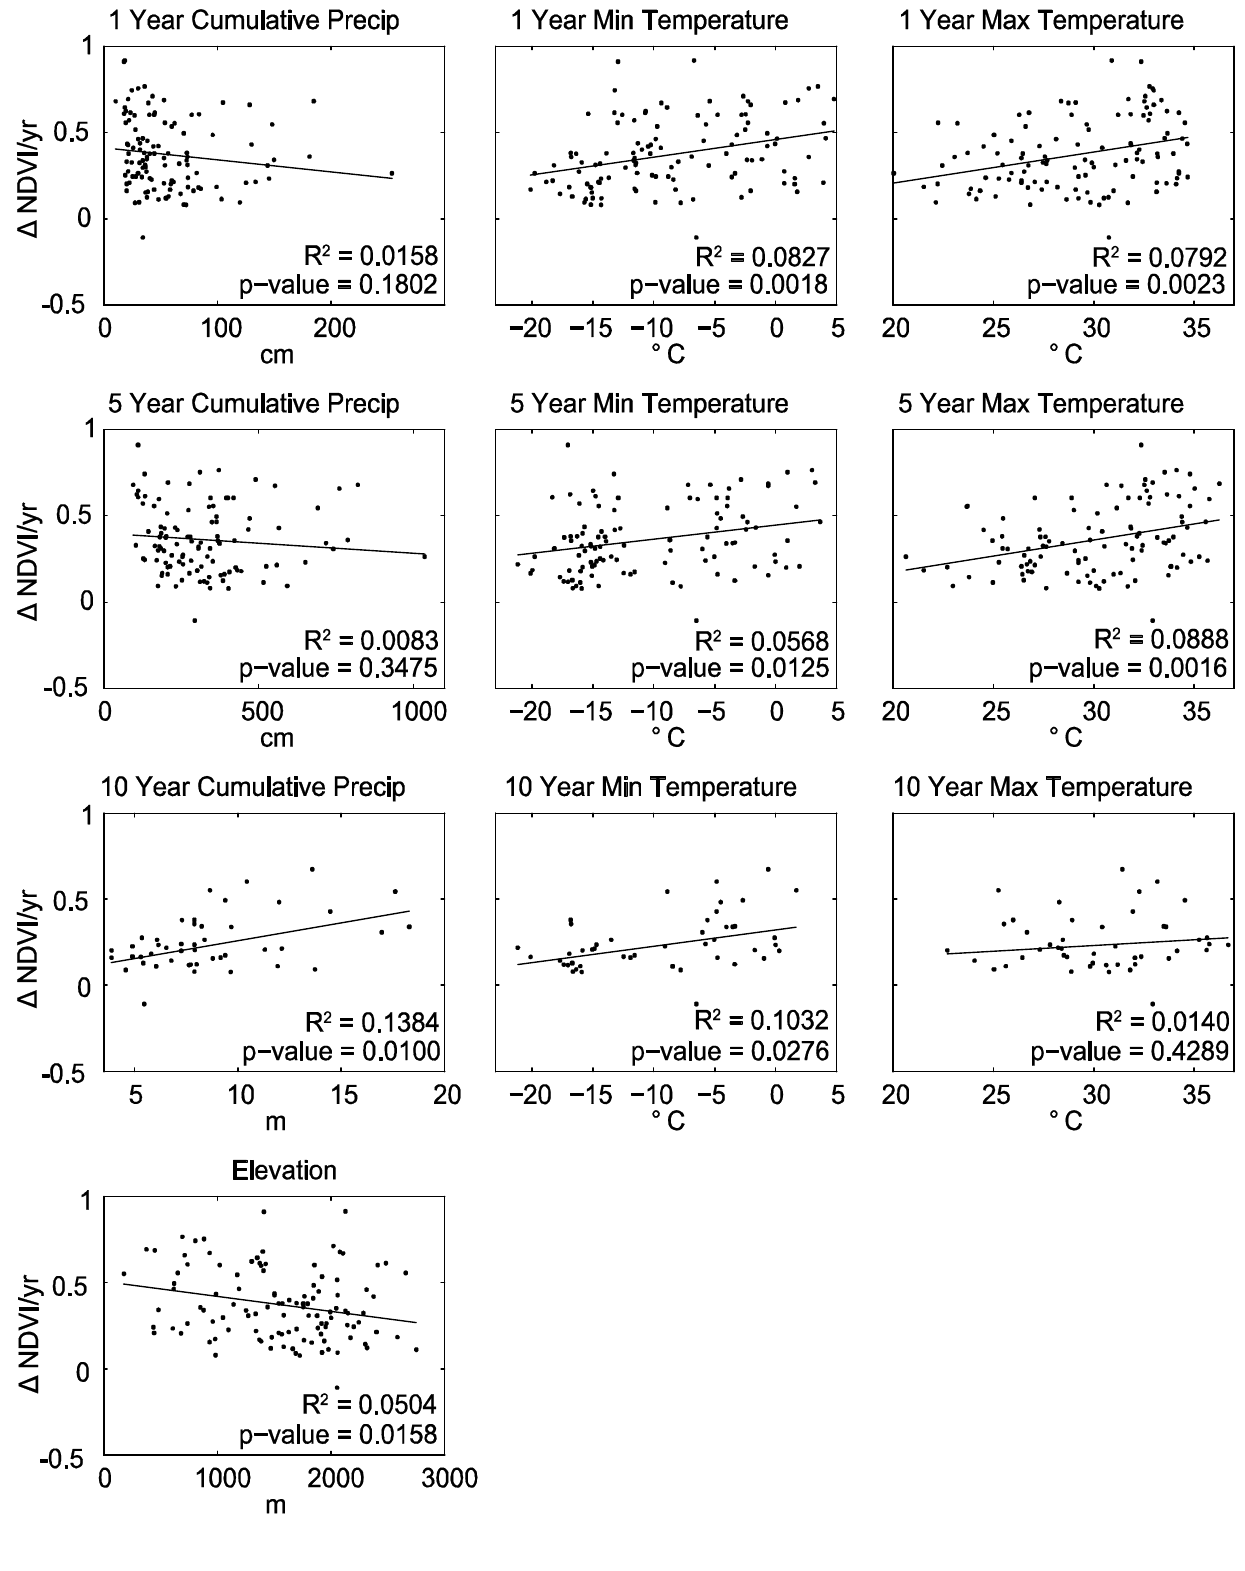
Figure 7. Scatterplots and least squared regression lines for the relationship between local-scale factors and post-fire NDVI